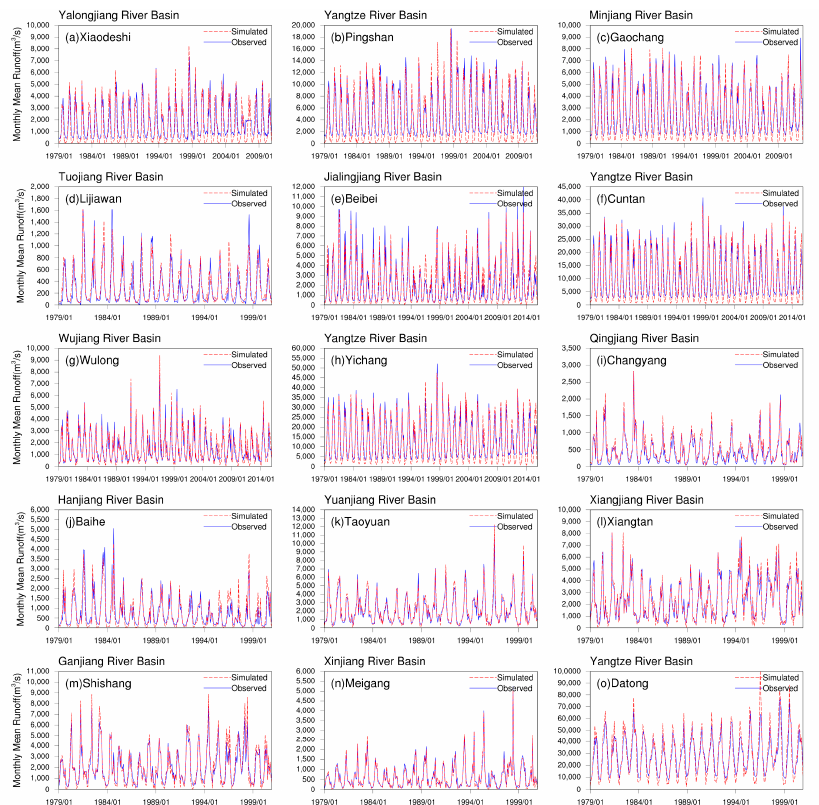
Figure 5. Simulated and observed discharge process of main hydrological stations in the Yangtze River Basin. ( a ) Xiaodeshi, ( b ) Pingshan, ( c ) Gaochang, ( d ) Lijiawan, ( e ) Beibei, ( f ) Cuntan, ( g ) Wulong, ( h ) Yichang, ( i ) Changyang, ( j ) Baihe, ( k ) Taoyuan, ( l ) Xiangtan, ( m ) Shishang, ( n ) Meigang, ( o ) Datong. Table 4. Simulation performance of discharge process at 15 hydrological stations in the Yangtze River Basin.